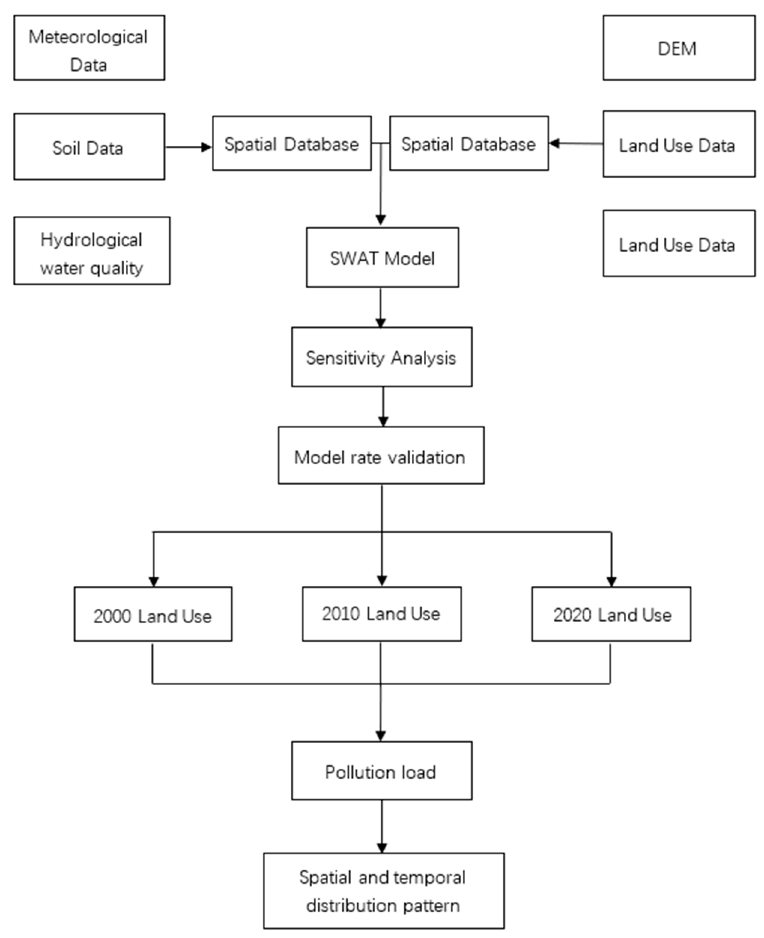
Figure 6. Flowchart of model.